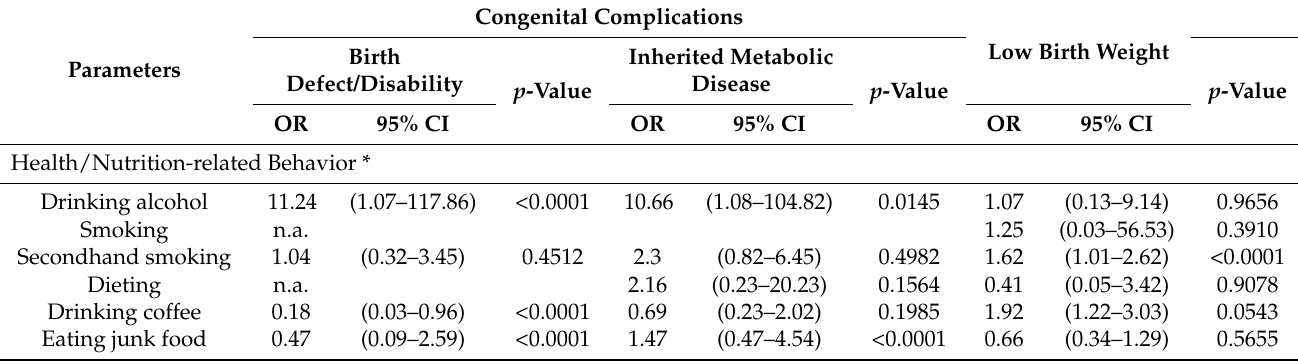
Table 2. Logistic regression analysis of association between maternal factors and congenital complications/low birth